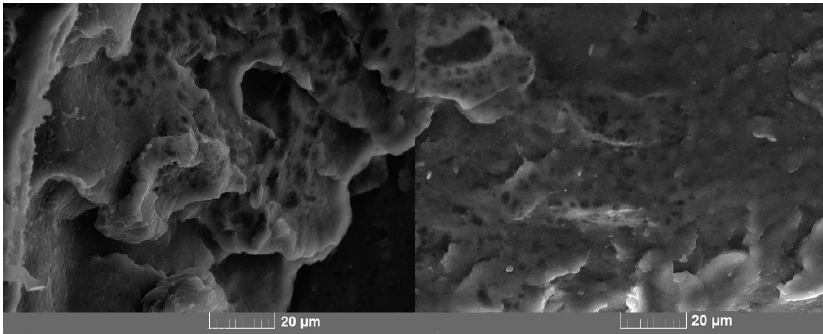
Figure 2. Microphotographs of a quasi-brittle fracture surface of a polymer blend. The DSC method was used to evaluate thermal transitions in the polymer blend. The method was performed in three stages: first heating, cooling, and second heating. The study results are shown in Figure 3.